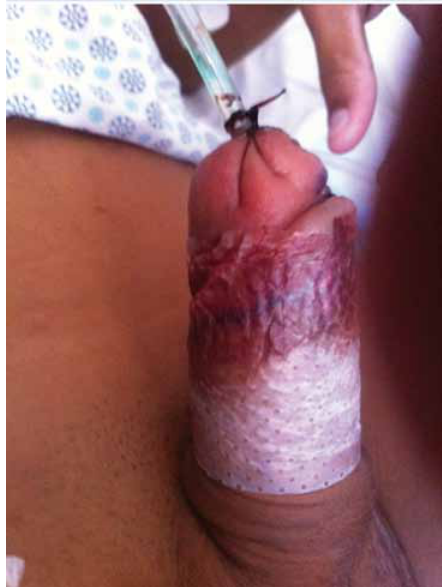
Figure 5 - Sugarcane biopolymer pellicle on the 8th day, before removal.